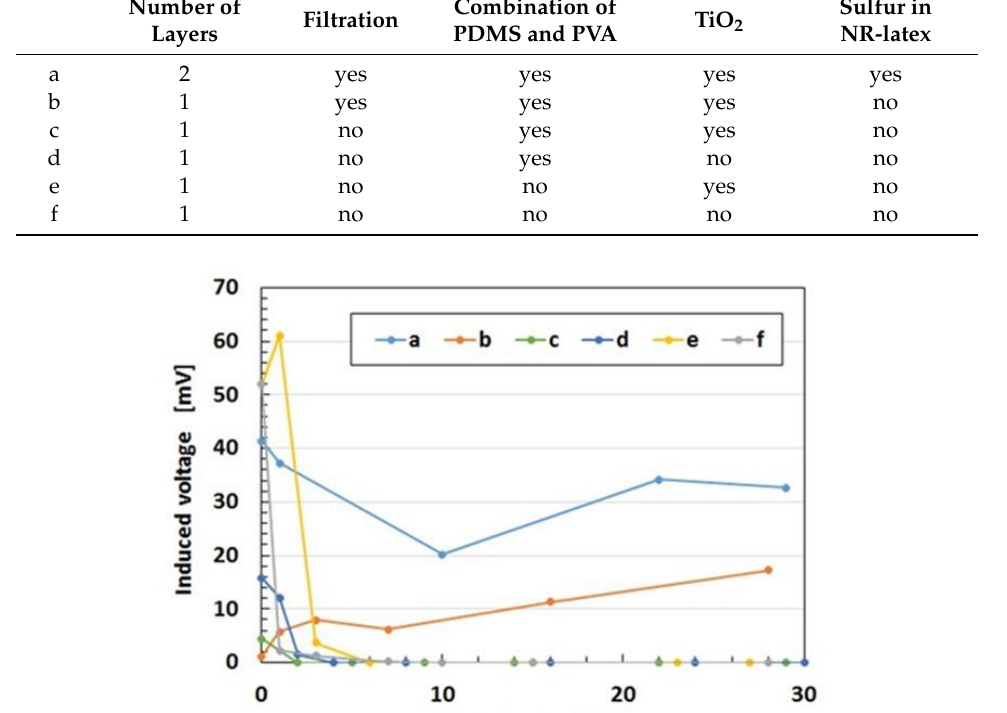
Table 2. Constitute of MCF rubber sensor in Figure 11 with 3 g NR-latex (Ulacol), 3 g CR-latex (671A),